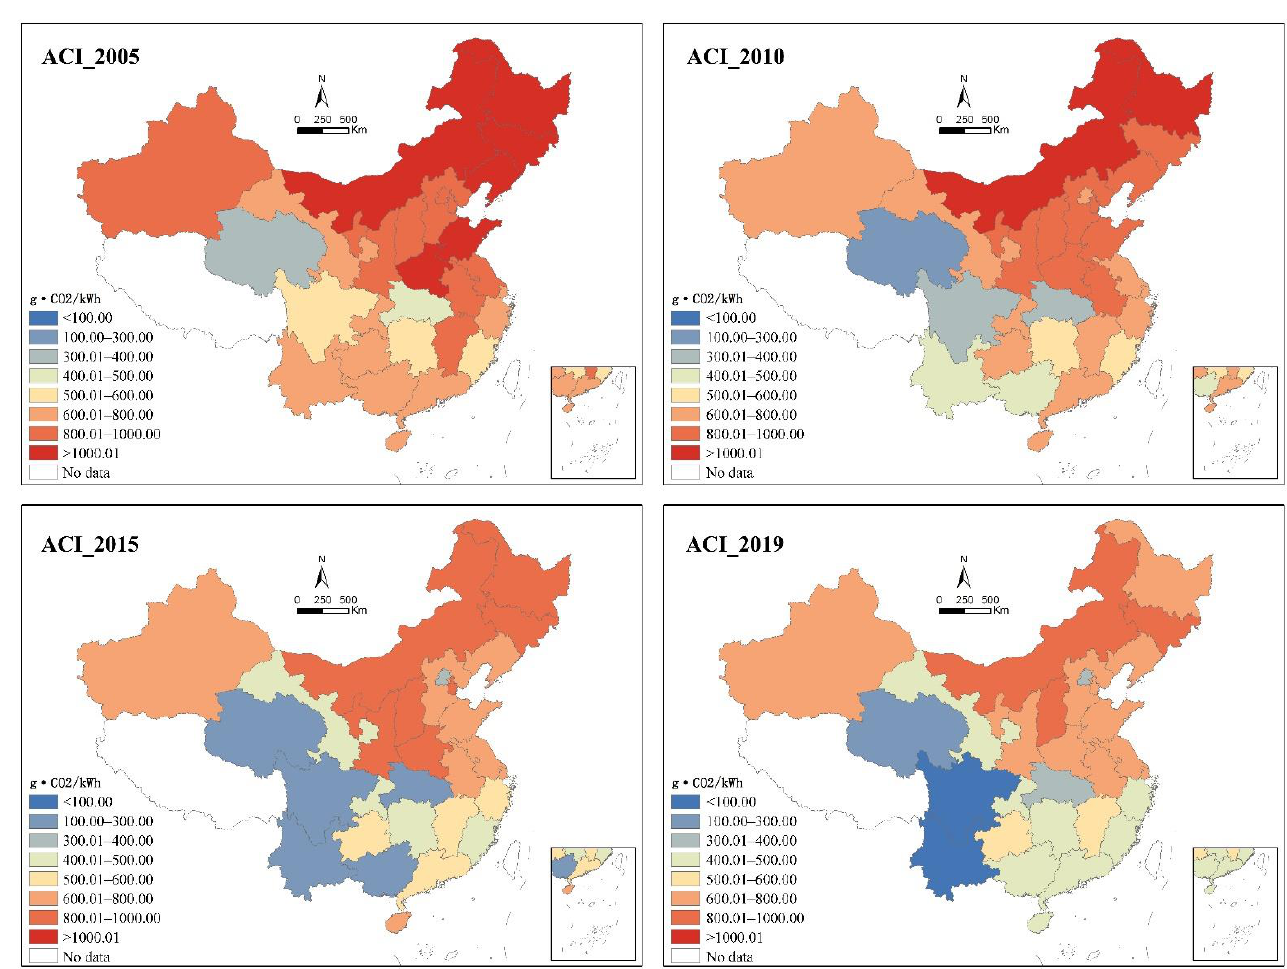
Figure 1. The spatial distribution of provincial ACI in China.